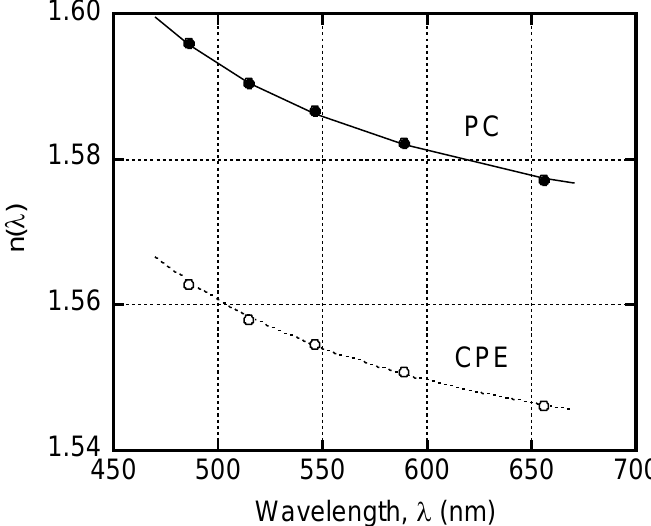
Figure 1. Wavelength dispersion of refractive index n ( λ ) for PC and CPE. The solid and dotted lines represent the calculated values using the Sellmeier equation.